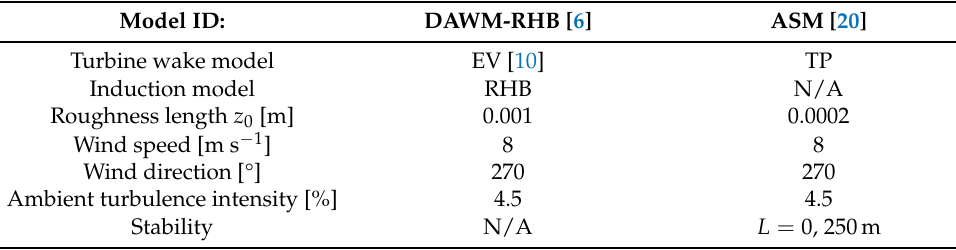
Table 1. Description of Openwind set-up and input parameters for each wake model for comparison with the LES results ( L is the Obukhov length). RHB refers to the implementation of the potental flow analytical model (or Rankie Half Body model) [15], ASM refers to Array-Stability Model and TP refers to the TurbOPark model